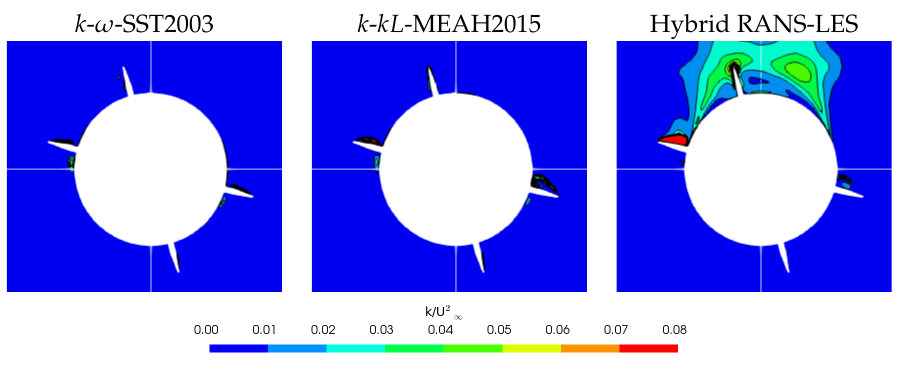
Figure 12. Comparison of RANS methods with available hybrid RANS/LES computation; M = 0.85, = 5 × 10 5 , λ = 45°, x / D = Re d Ref